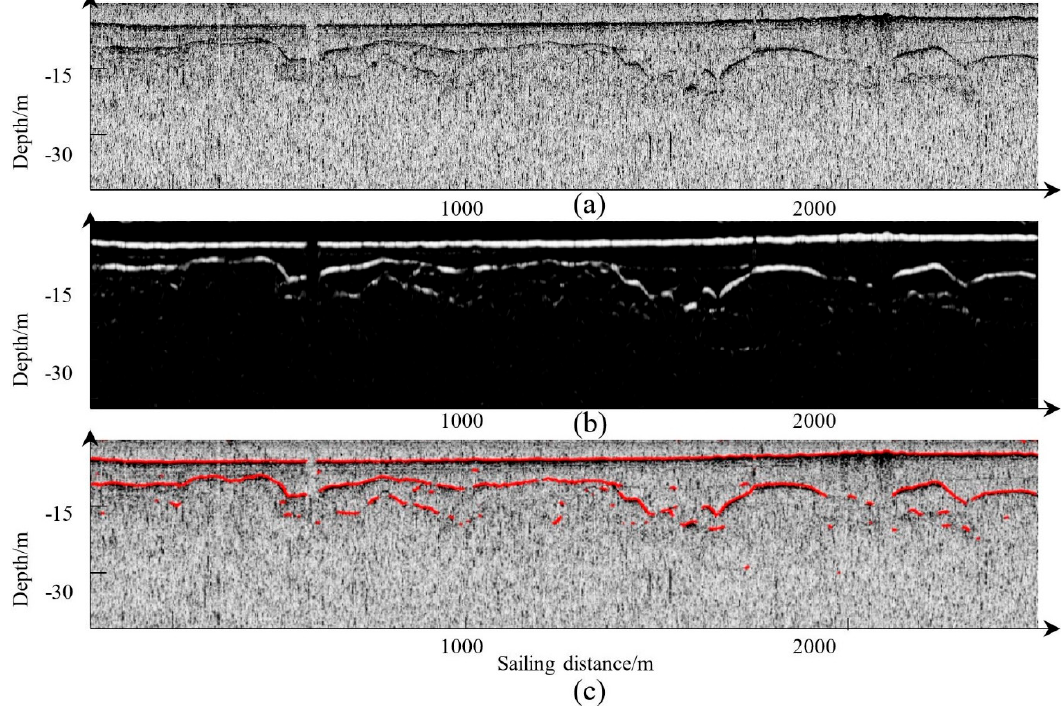
Figure 11. The original SBP image and the resulting images. ( a ) shows the original SBP image. ( b ) shows the filtered image. Picking horizons from ( b ), ( c ) shows the superposition of the picked horizons and the original SBP image.